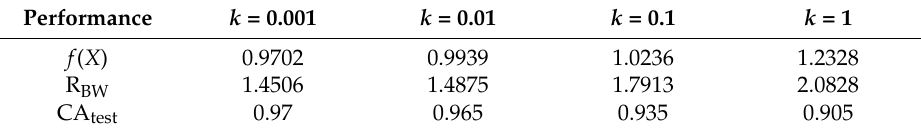
Table 2. The results of evolutionary process with different values of parameter k.